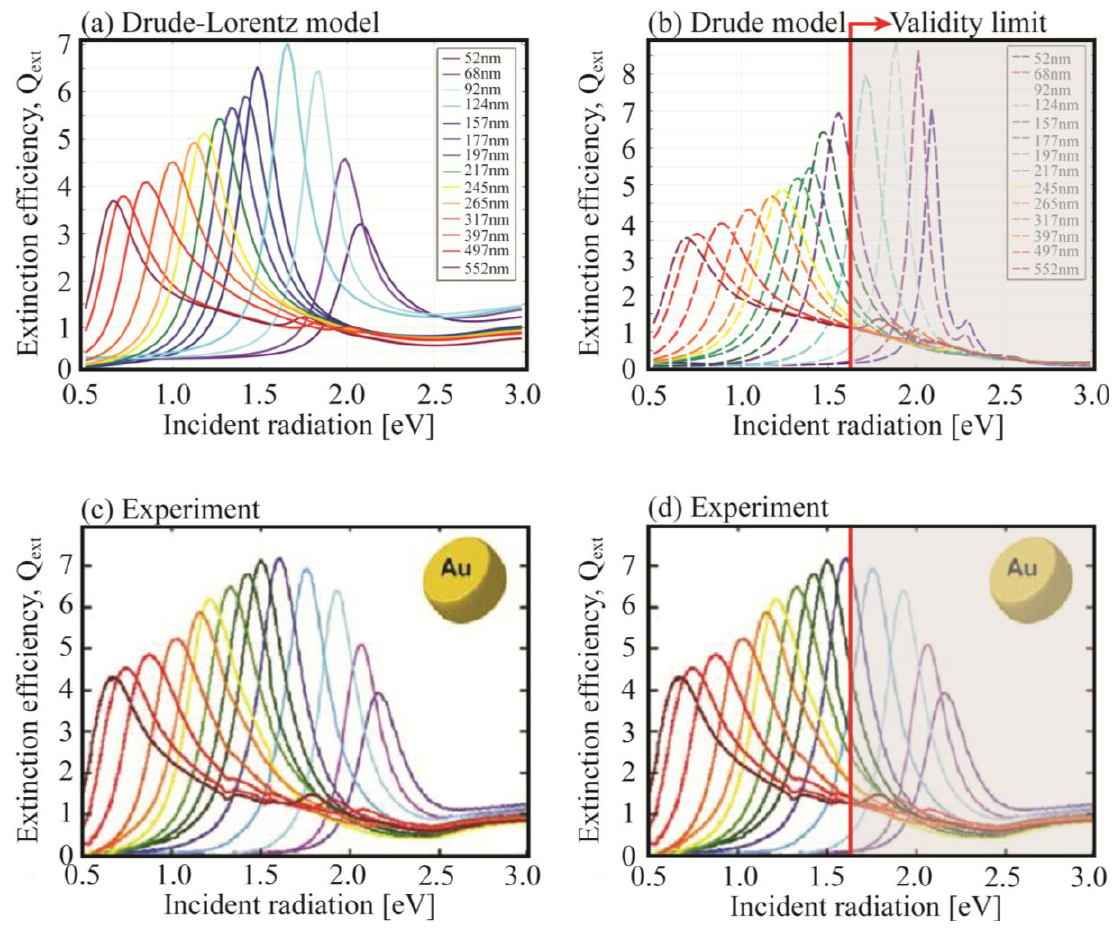
Figure 7. Extinction efficiency of Au nanodisks of different diameters at a fixed height H = 20 nm. ( a ) Drude-Lorentz model (see Equation (10)); ( b ) Drude model with ε The red line highlights the validity range of the Drude model ( c , d ) Experimental measurements from [64]. The red line highlights the validity range of the Drude model. Reprinted with permission from [64]. Copyright 2011 American Chemical